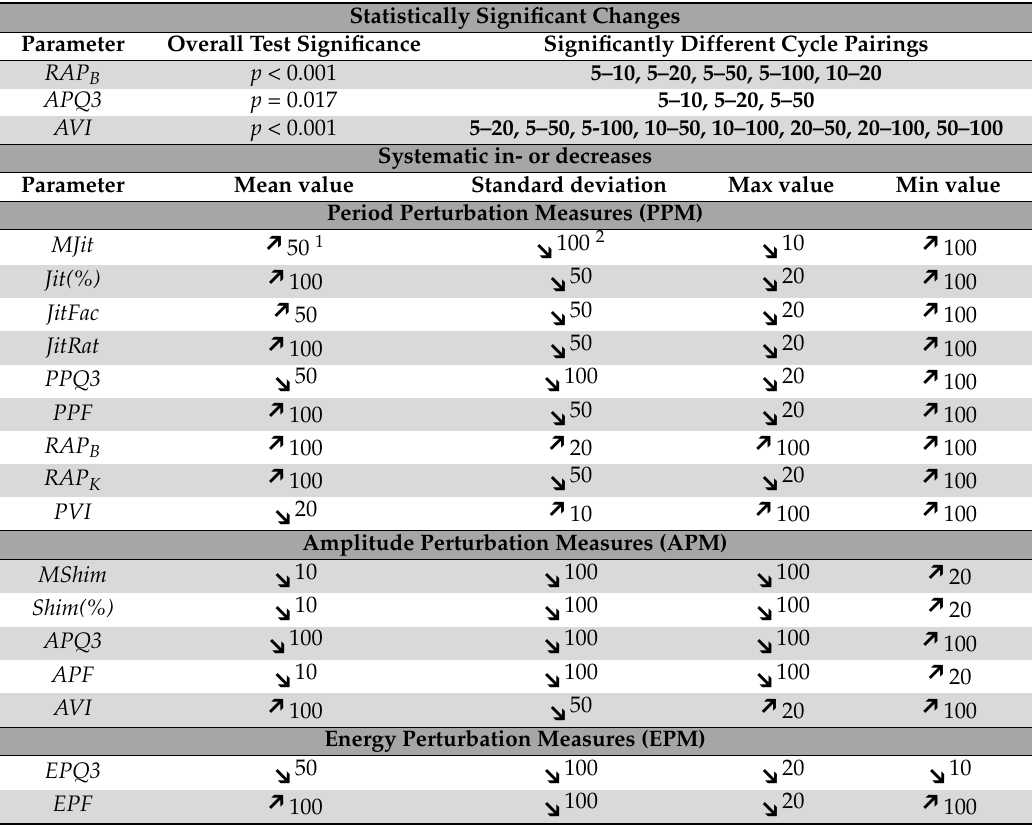
Table 2. Statistically significant parameter changes and observed systematic in- or